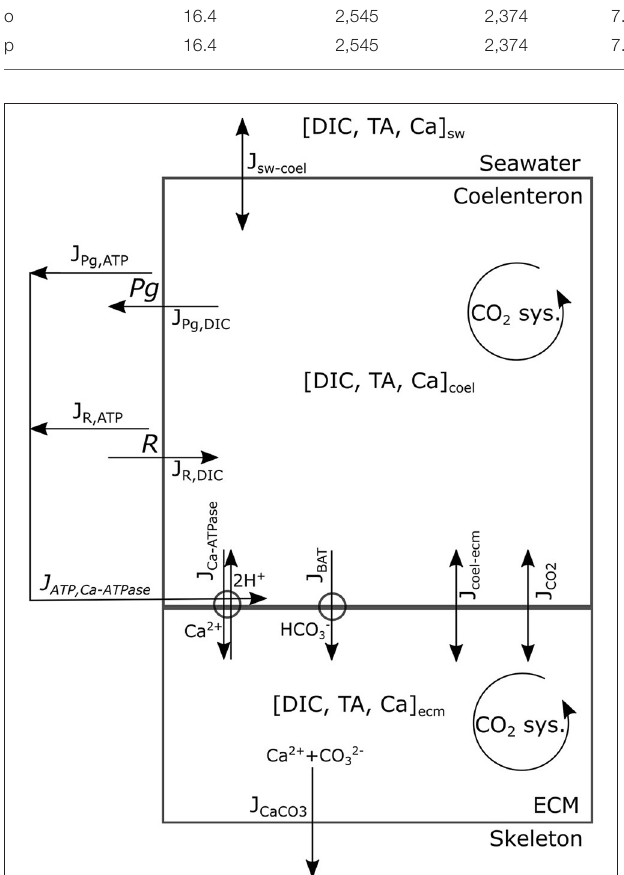
epitelium and ECM. A scheme of the model is provided in Figure 1 , all model parameters and sources are listed in Table 2